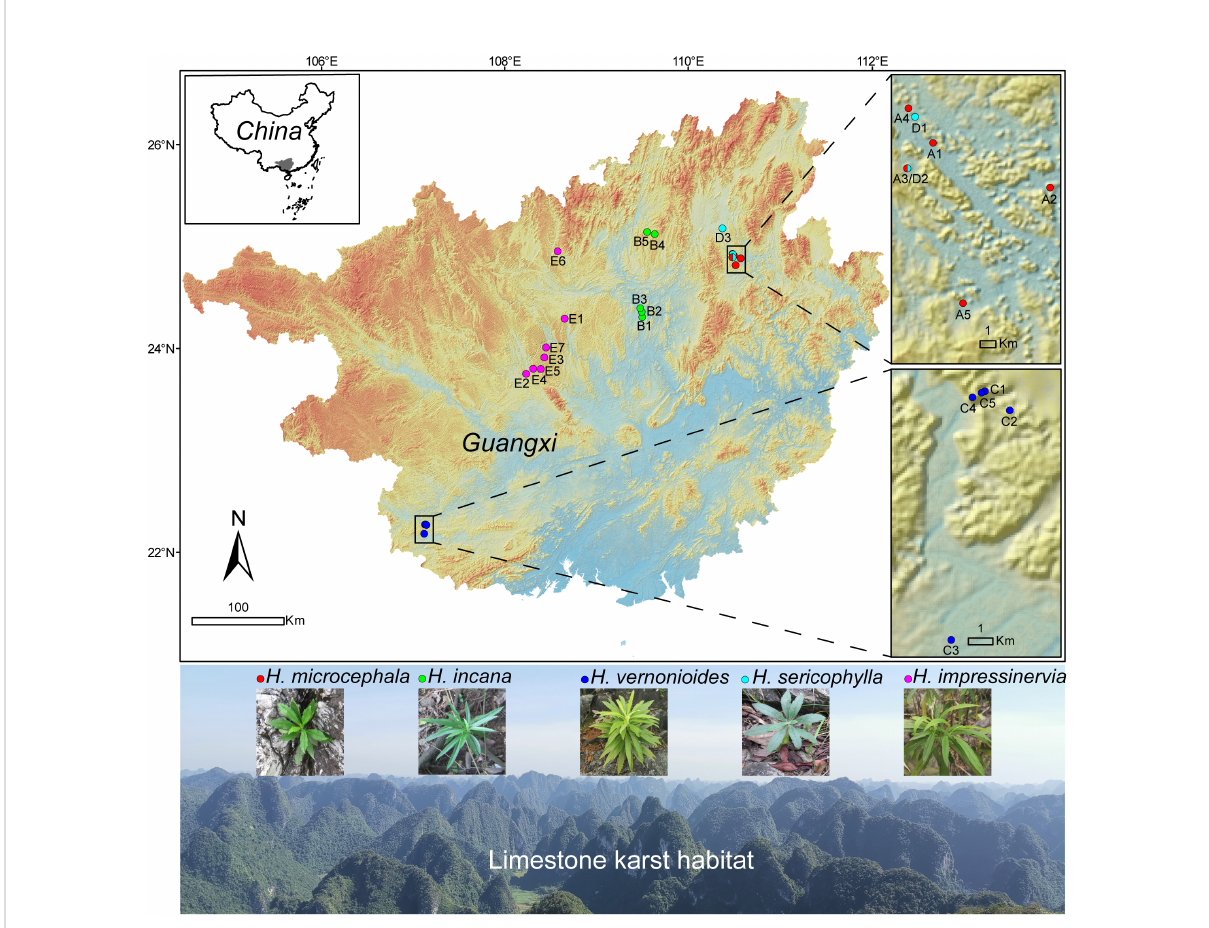
FIGURE 1 Map of the sampling sites and habitats of the fi ve Heteroplexis species. Populations were color-coded by species. Site numbers correspond to the population numbers listed in Table S1. The map was downloaded from Geospatial Data Cloud